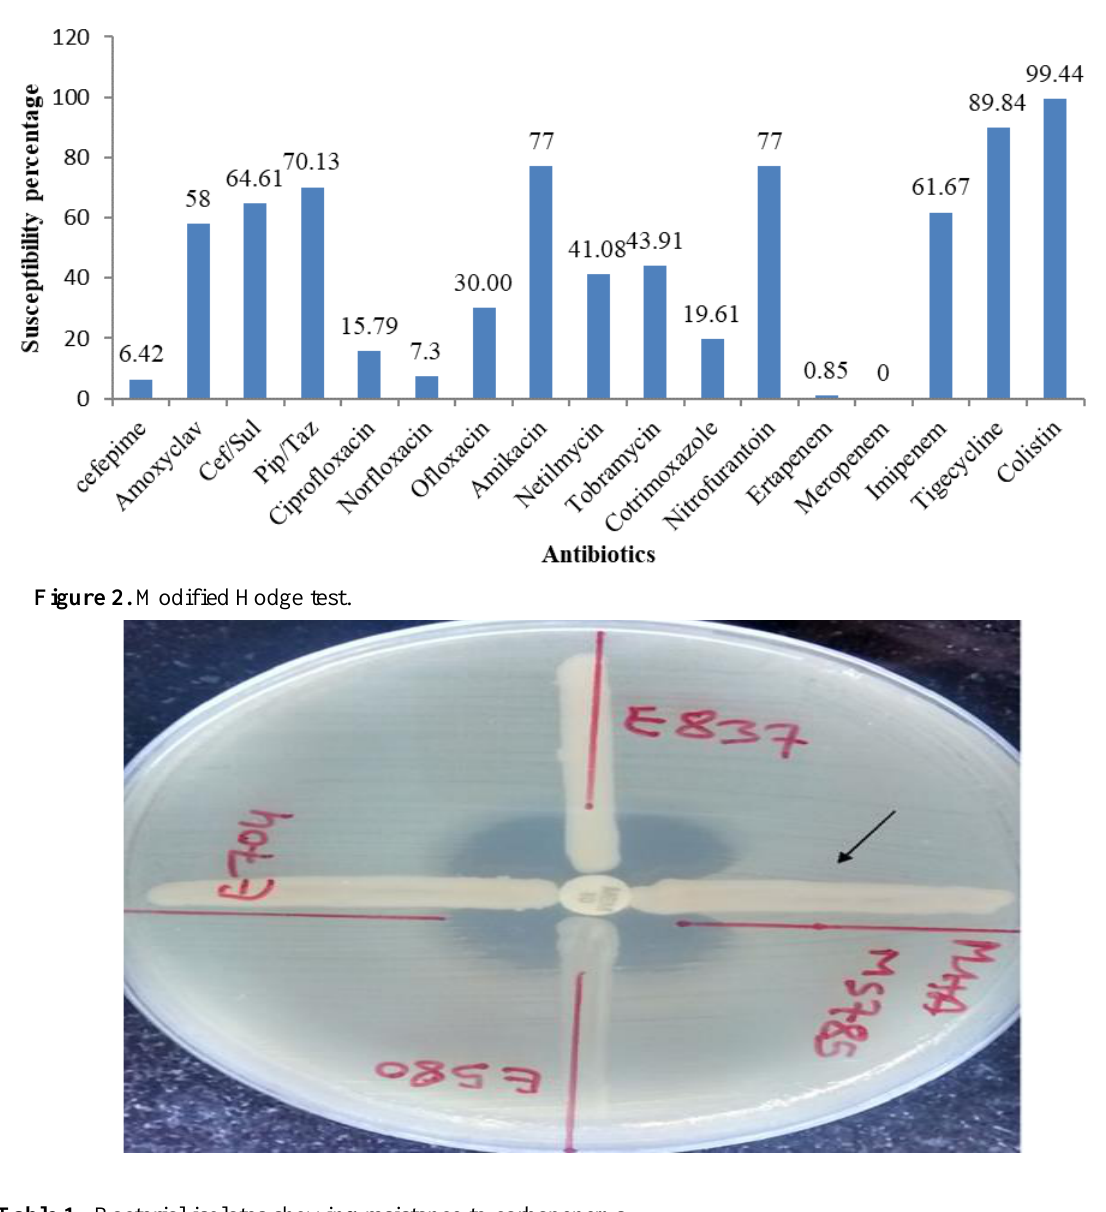
Figure 1 . Antibiotic susceptibility pattern.